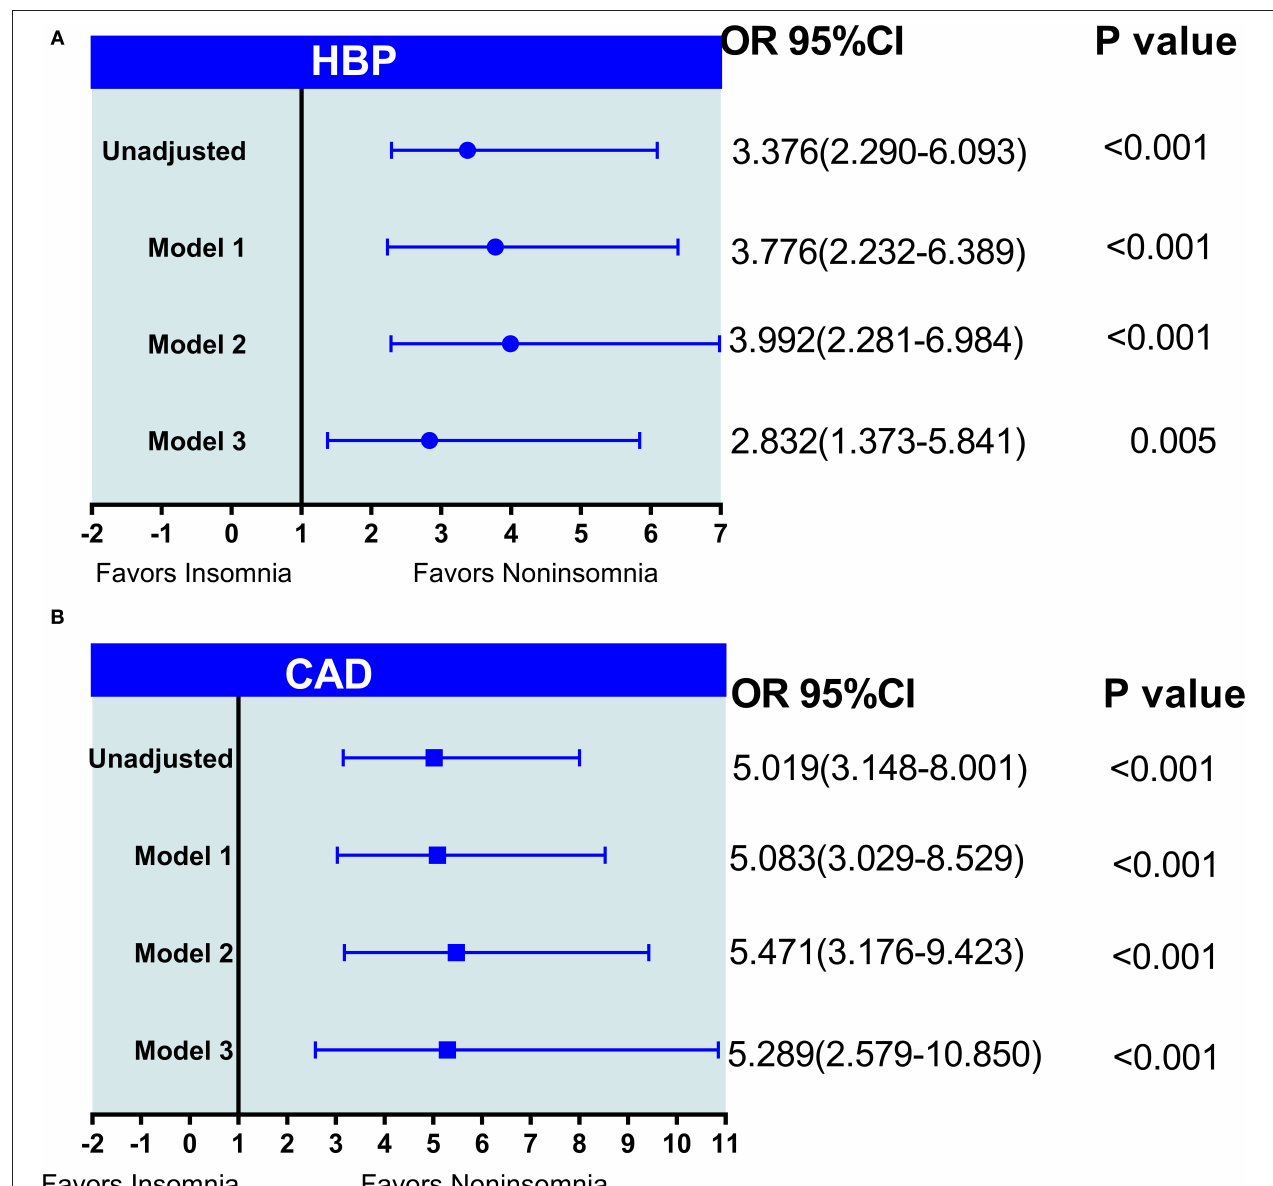
FIGURE 3 | (A,B) The logistic regression analysis of insomnia with HBP and CAD in patients with type 2 diabetes mellitus (T2DM). Model 1: adjusted age, gender, body mass index (BMI), smoking, and alcohol use; model 2: adjusted model 1 + (family history of T2DM, TG, triglyceride; TC, total cholesterol; HDL, high-density lipoprotein; LDL, low-density lipoprotein; VLDL, very low-density lipoprotein; BUN, blood urea nitrogen; Scr, serum creatinine; HbA1c, glycosylated hemoglobin A1c; FBG, fasting blood glucose, and insulin therapy); model 3: model 2 + (duration of T2DM > duration of